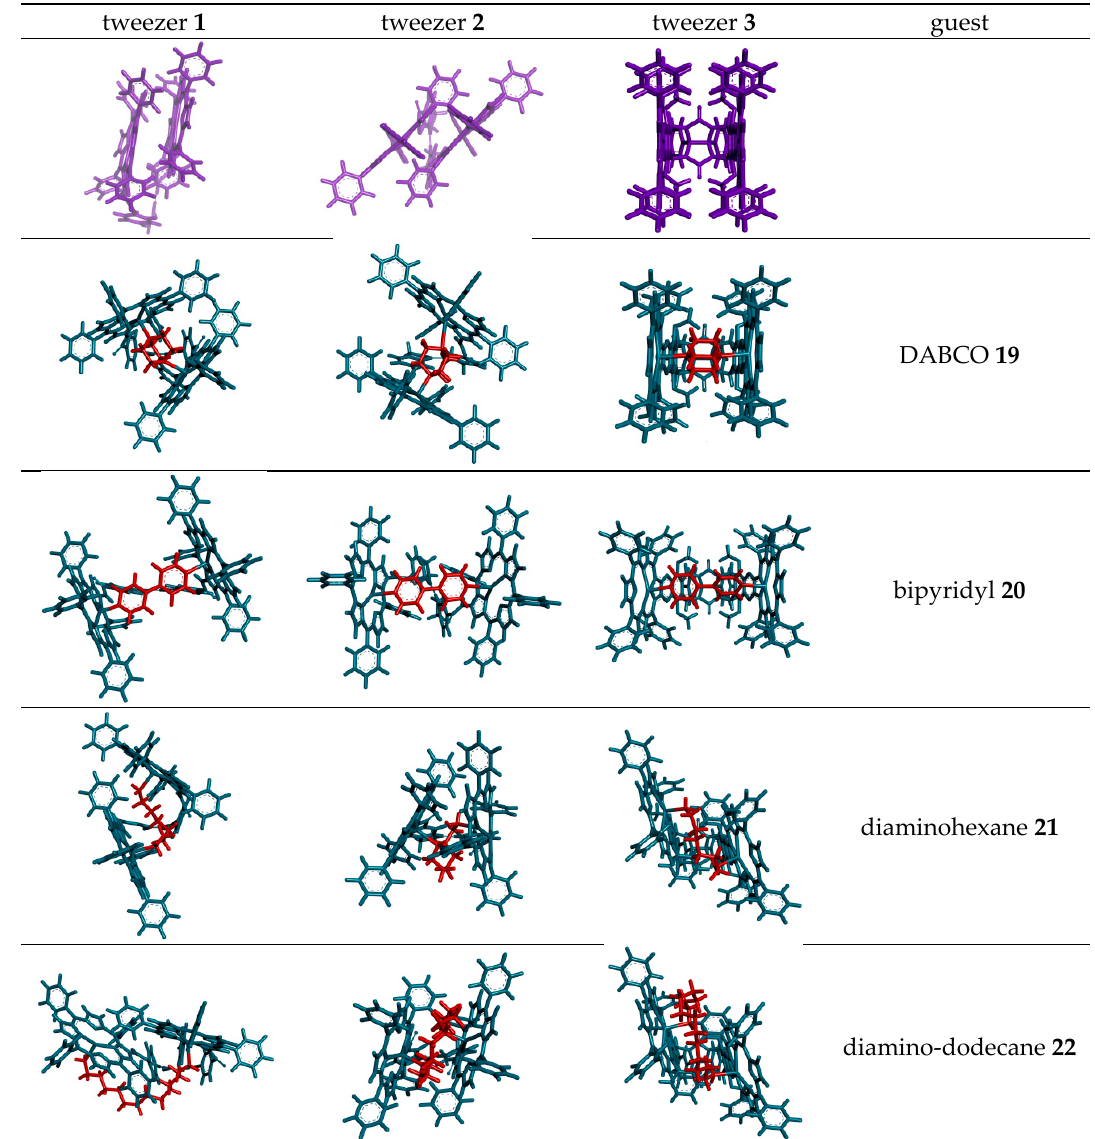
Scheme 4. Maximal distance between nitrogen atoms for the guest molecules used in this study.